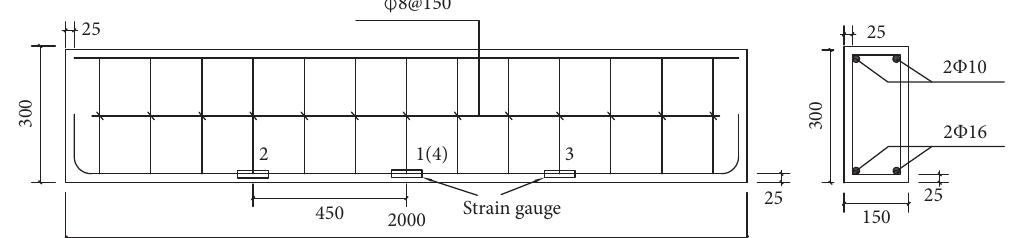
Figure 1: Reinforcement diagram of the Group A beam (mm).